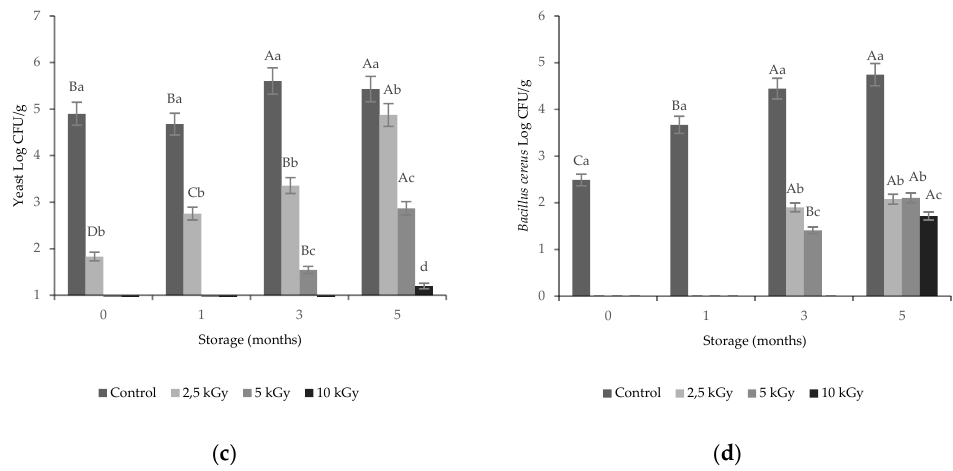
Figure 1. The microbiological changes and pest formation during the storage of irradiated and control tarhana samples. ( a ) Pest formation, ( b ) total aerobic mesophilic bacteria (TAMB), ( c ) yeast and ( d ) Bacillus cereus counts. Capital letters represent the p < 0.05 level of statistical di ff erence between the storage times of the tarhana samples, while the lower-case letters show the p < 0.05 level of statistical di ff erence between the irradiation doses.